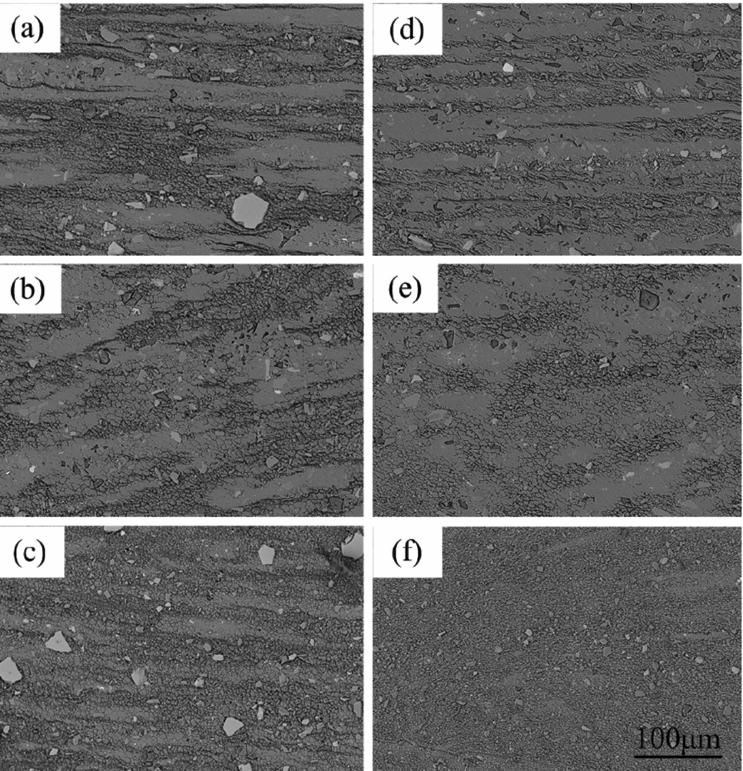
Figure 6: Si particles distribution: (a) upper, (b) middle and (c) lower regions of air cooling FSP specimen, (d) upper, (e) middle and (f) lower regions of water cooling FSP